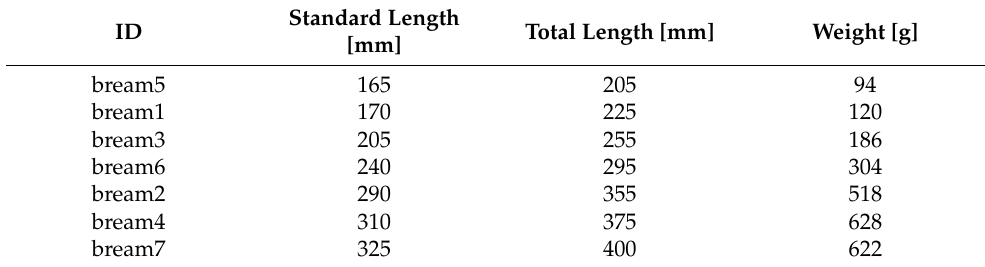
Figure 1. Illustration of experimental design for collecting hydroacoustic data of anesthetized fish of known size with controllably adjustable dorsal body orientation. ( A ) Fish positioned in true dorsal body orientation. ( B ) Fish positioned at tilt angle with head closer to the transducer, i.e., in head-up dorsal orientation. Table 1. Body measurements of the common bream Abramis brama (L.) observed in dorsal aspect using pulse-compressed broadband acoustic pulses. The data is sorted in ascending order of fish